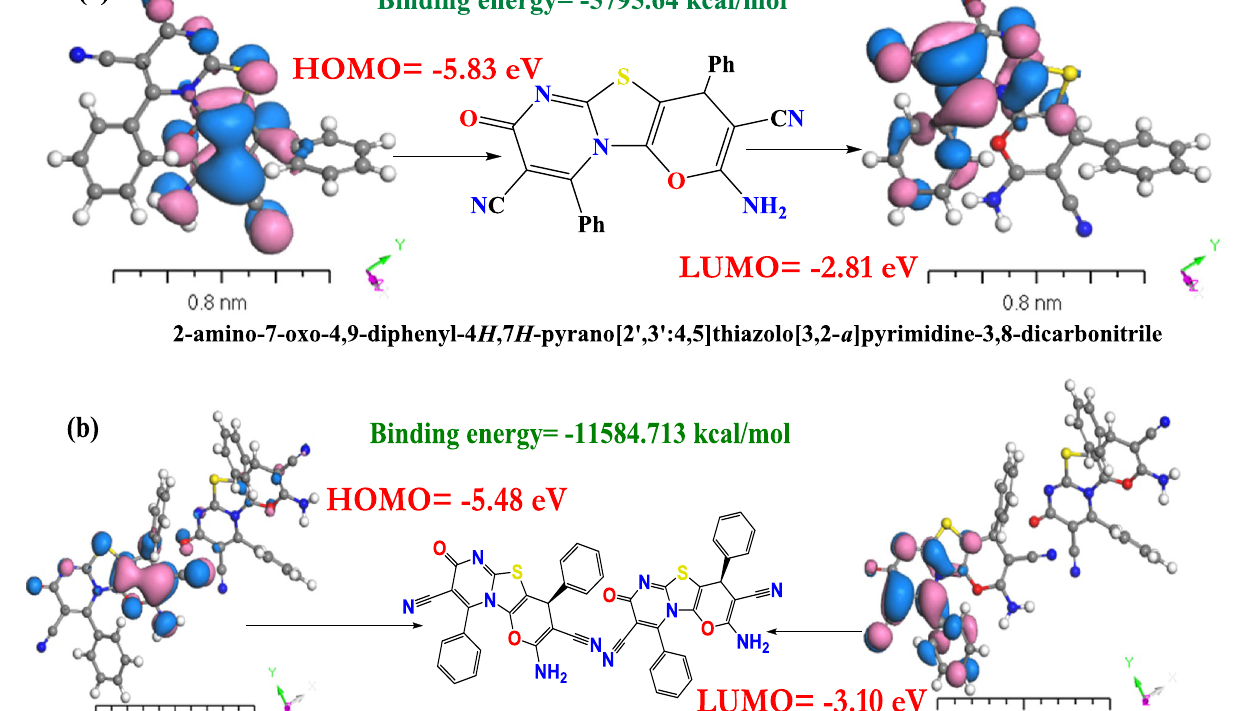
Opt g ) , global hardness (η), chemical potential (μ),